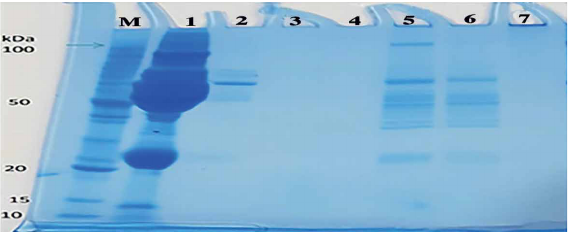
Figure 2: Evaluation of the effectiveness of washing of the culture twice or thrice with PBS. Lane M-Ladder, lane 1 represents 1 st spin, 2–4 represent three consecutive supernatants that were collected after washes, lanes 5–7 represent the pellet that was treated with triton-X, β PL, and F,